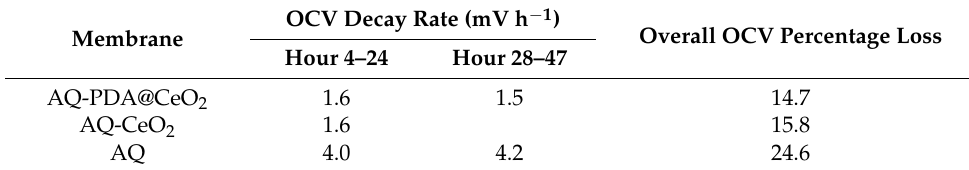
Table 3. OCV decay rate for the indicated membranes at 80 ◦ C and 50% RH.